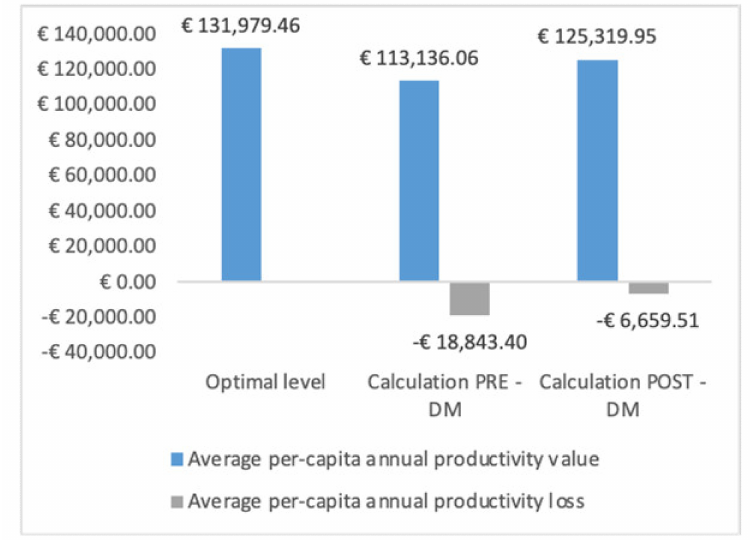
Figure 1. Value of the average annual net productivity